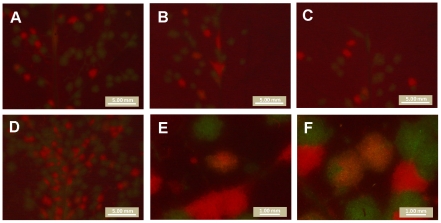
Mixed-genotype foci of primary infection in the inoculated leaf.Plants were infected with 1∶30 dilution of a mixture of amplified TEV-GFP and TEV-mCherry virions, kept on ice for 0 h (panel A), 2 h (panel B) or 3 h (panel C). Yellow, mixed-genotype foci were observed at low frequency at all three time points (1.8% averaged for all three times), and the frequency of mixed-genotype foci did not change significantly over time (test for a trend in proportions: χ2 = 0.041, 1 d.f., P = 0.839). Plants were also infected with a 1∶10 dilution of the same mixture (Panel D): the number of mixed-genotype foci may be higher, but these leaves could not be quantitatively scored. High magnification pictures of yellow foci are also provided (Panels E and F). Note that the distribution of red and green fluorescence is not homogeneous within yellow foci.